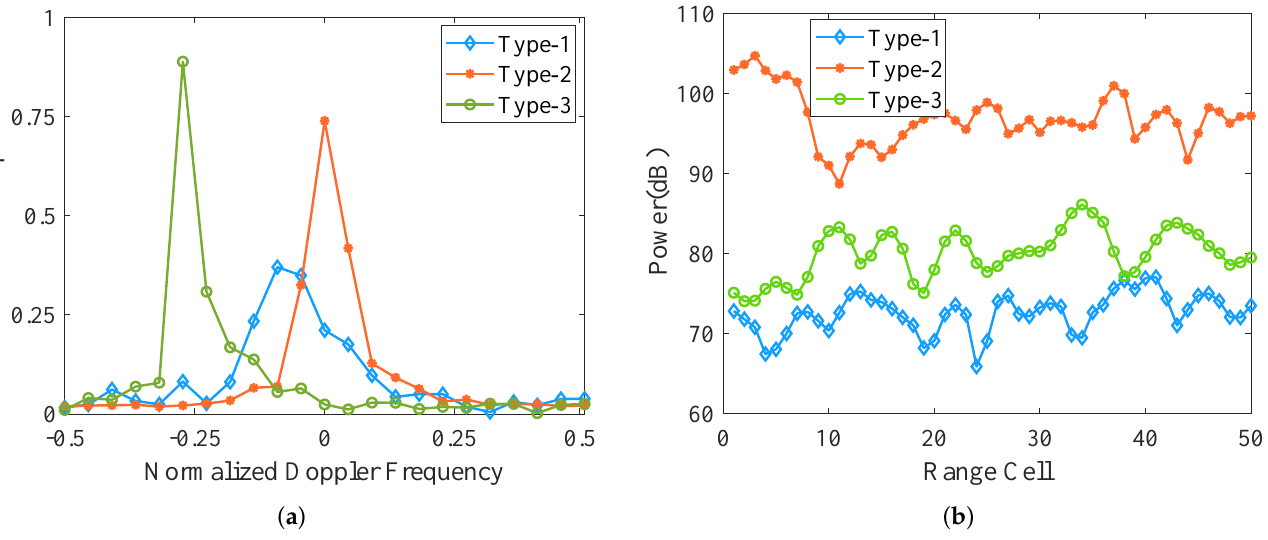
Figure 6. Characteristics of the three types of clutter. ( a ) Doppler characteristics; ( b ) Power compari- son of three types of clutter part range